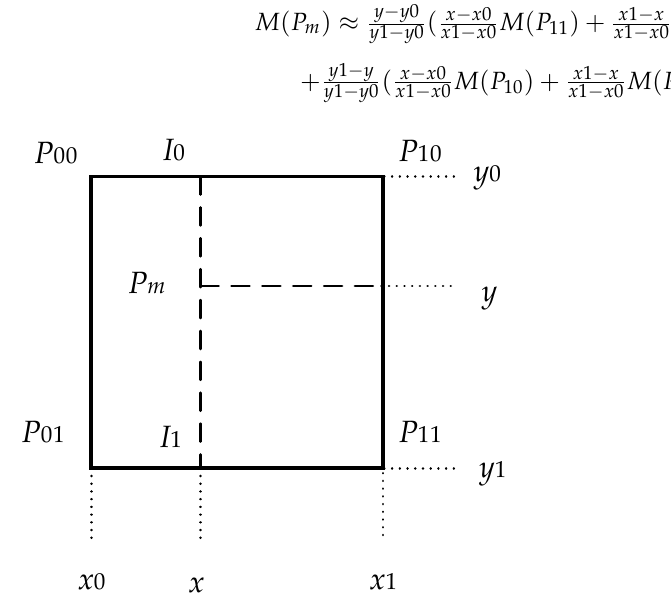
Figure 5. Bilinear Figure 5. Bilinear interpolation.